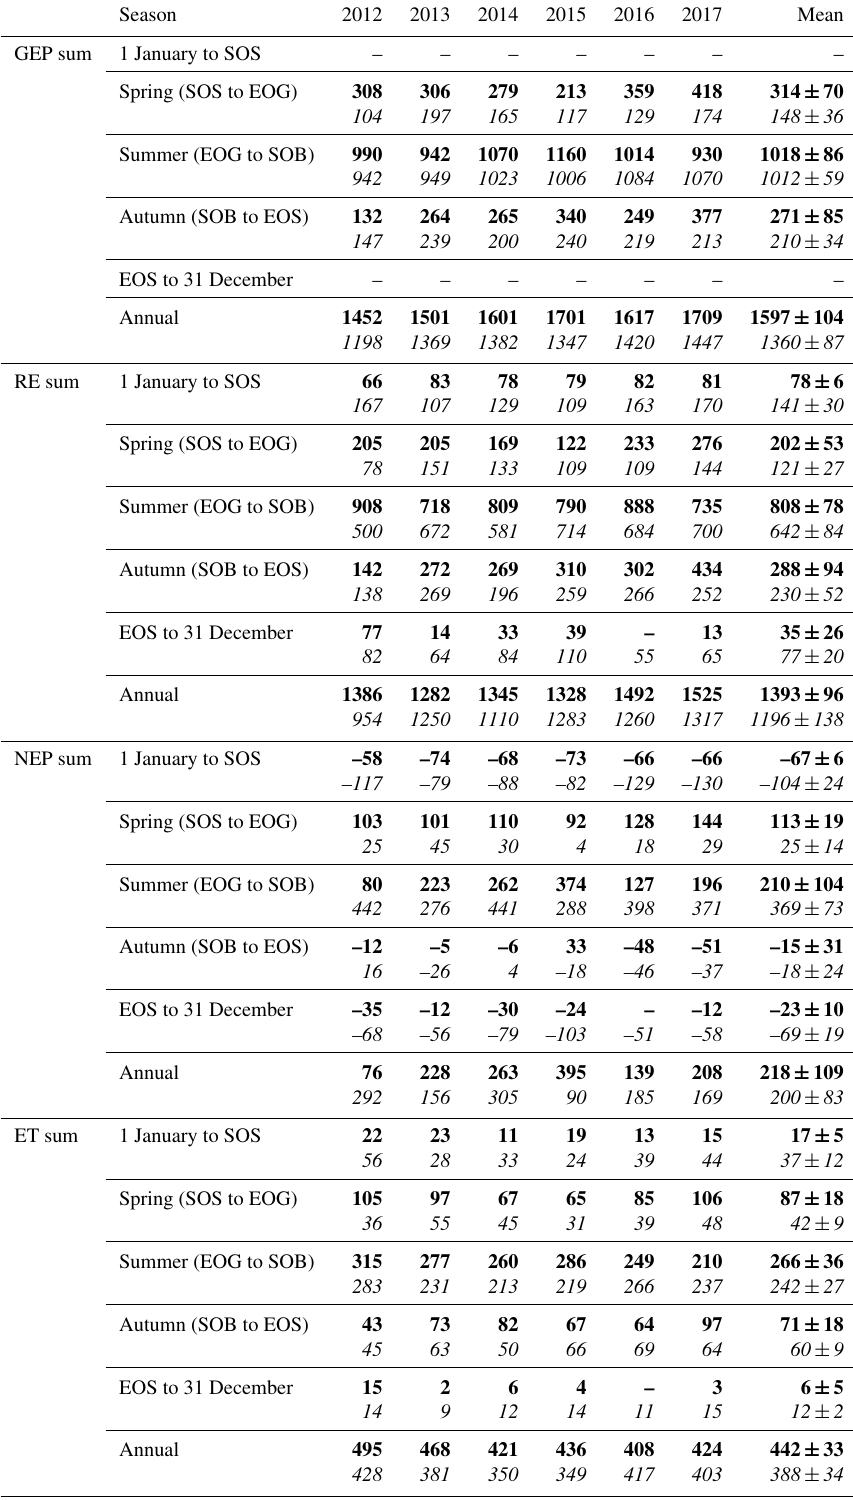
Table 3. Seasonal and annual sums of eddy-covariance-measured carbon (GEP, RE, and NEP, gCm − 2 yr − 1 ) and water fluxes (ET, mmyr − 1 ) from 2012 to 2017 for both the conifer (TP39, bolded) and deciduous (TPD, italicized) forests. The phenologically defined seasonal dates were calculated using the timing of transitions in phenological dates, outlined in Table 2. The 6-year mean and standard deviations are also included for each